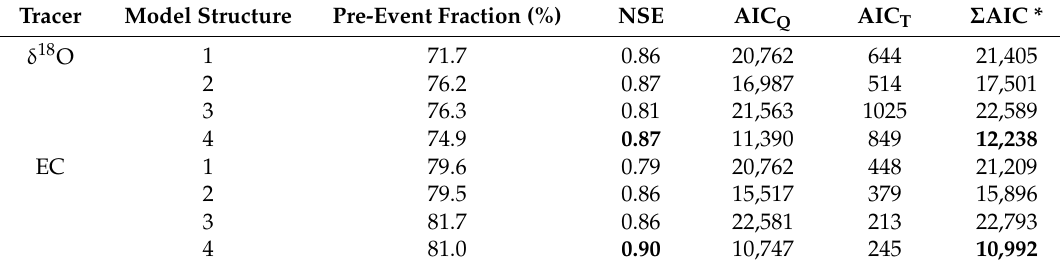
Table 3. TraSPAN model performance in terms of the mean Nash-Sutcliffe efficiency (NSE) for discharge and tracer concentrations and the Akaike Information Criterion for discharge (AIC Q ) and tracer (AIC T , i.e., δ 18 O or EC)